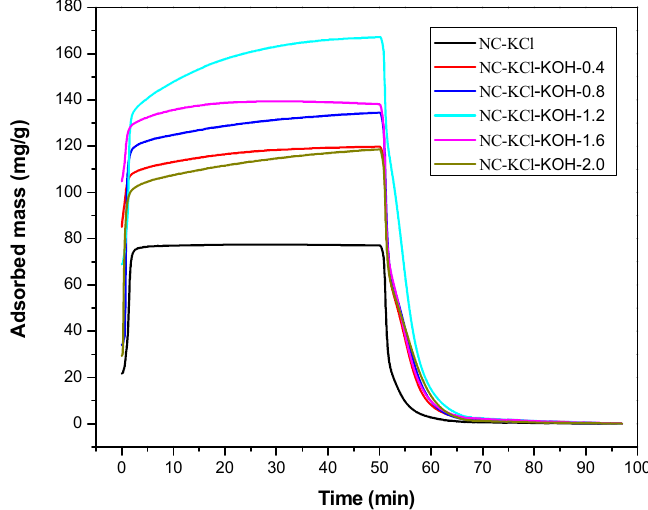
Figure 4. TG curves measured CO 2 adsorption and desorption of samples activated by different amount of KOH and 0.75 g KCl per 2.20 g resorcinol.